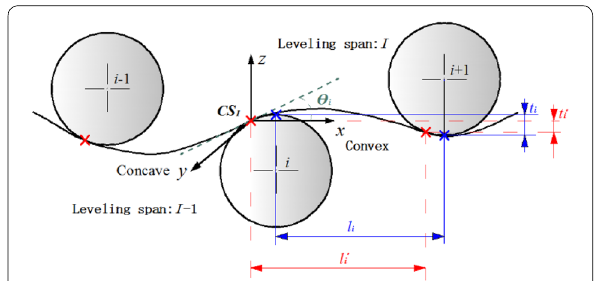
Figure 2 Plate roller leveling process